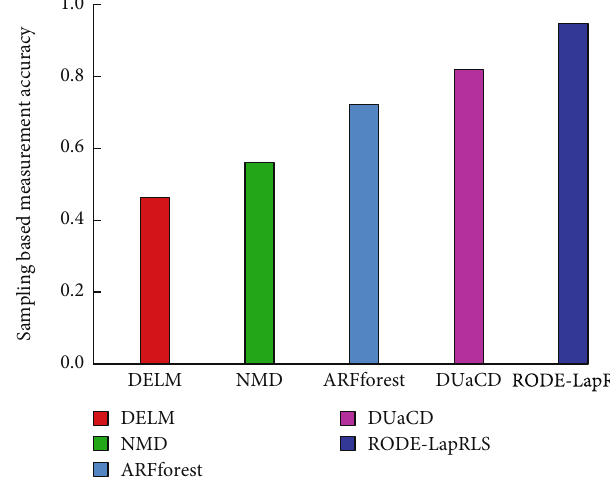
Figure 5: Model performance comparison.